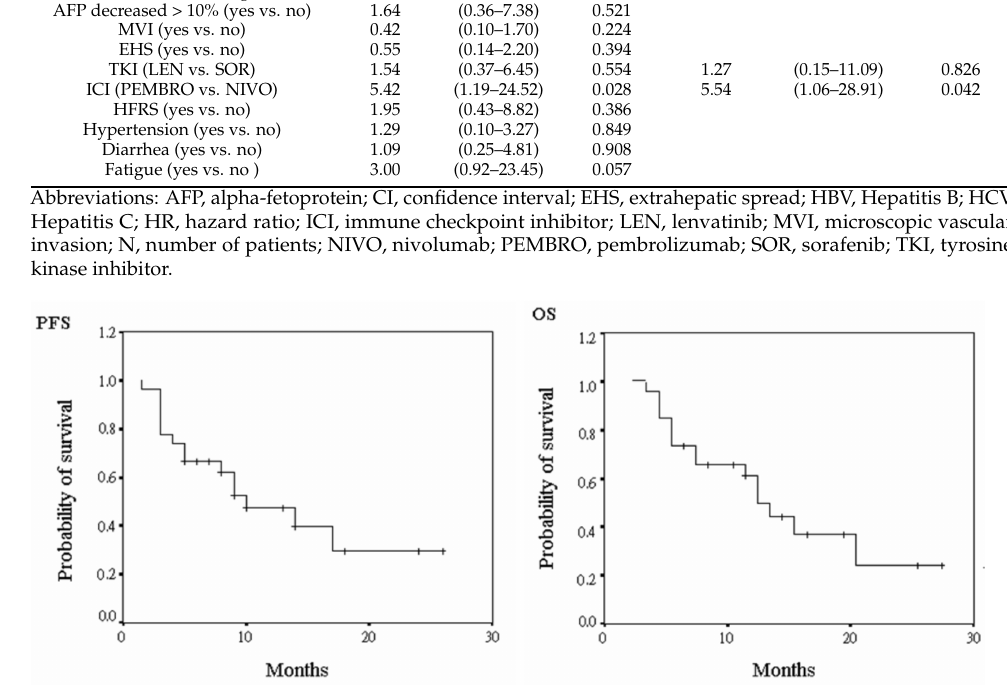
Figure 1. The survival time of hepatocellular carcinoma patients receiving combination therapy. (PFS, progress free survival; OS, overall